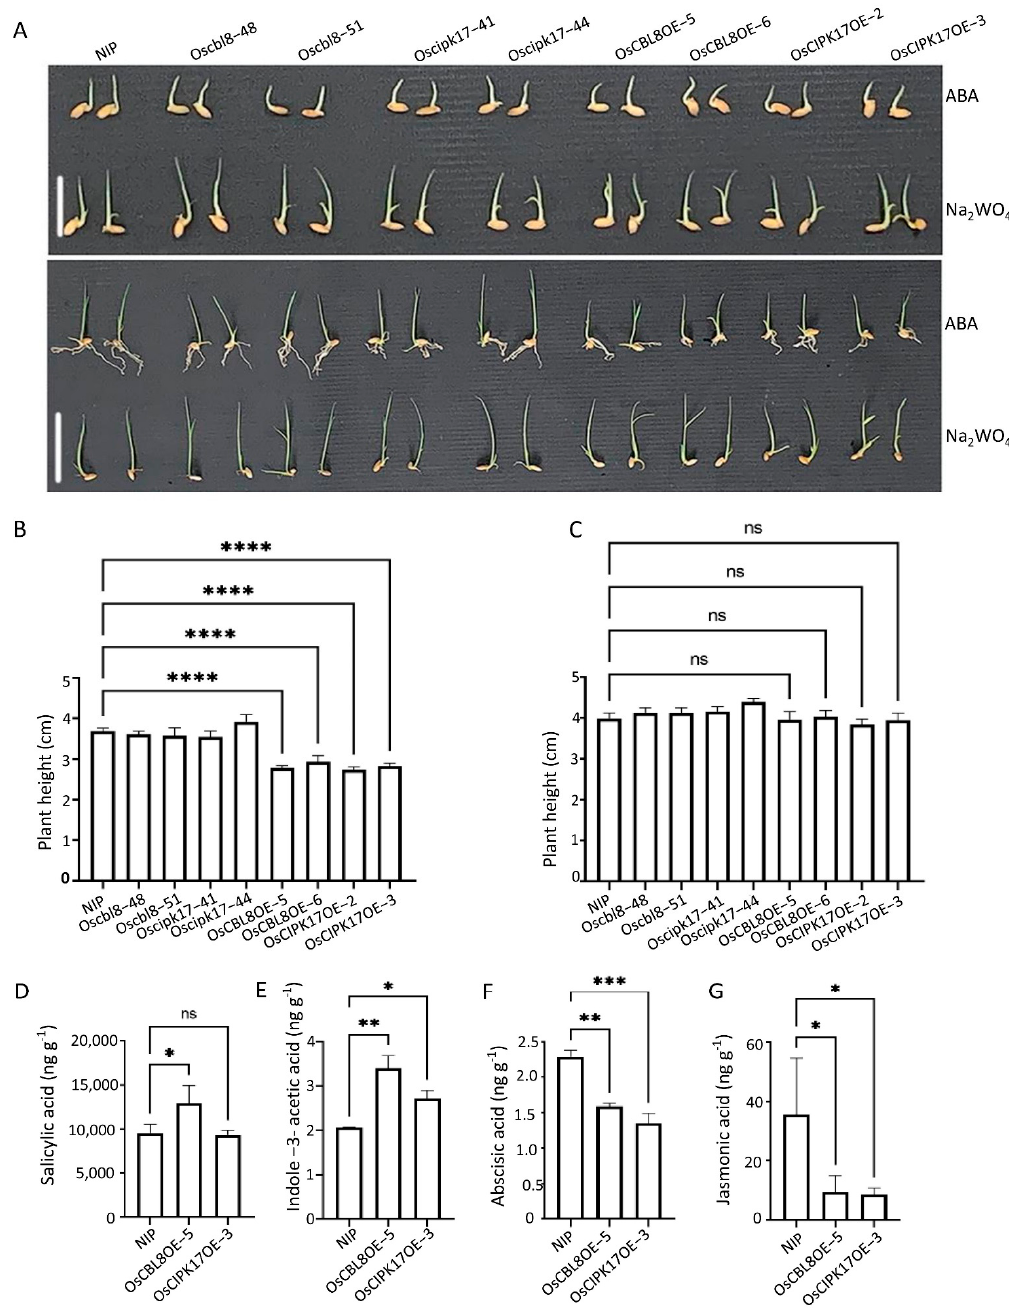
Figure 7. ABA participates in OsCBL8–OsCIPK17 module to regulate the growth of rice seedlings. ( A ) Phenotypes of seeds treated with 5 mg L − 1 ABA and 100 mg L − 1 Na 2 WO 4 for 1 and 2 weeks, respectively. The bars are 2 and 4, respectively. ( B , C ) Plant height of seeds treated with 5 mg L − 1 ABA and 100 mg L − 1 Na 2 WO 4 for 2 weeks. Data are mean ± SD from 10 biological replicates. Statistical analysis was performed using Dunnett’s multiple comparisons test; **** p < 0.0001; ns: no significance. ( D – G ). Determination of hormone content in leaves of 2-week-old seedlings of different lines. Data are mean ± SD from three biological replicates. Statistical analysis was performed using Dunnett’s multiple comparisons test; **** p < 0.0001; ns: no significance. * p < 0.05, ** p < 0.01, *** p < 0.001; ns: no